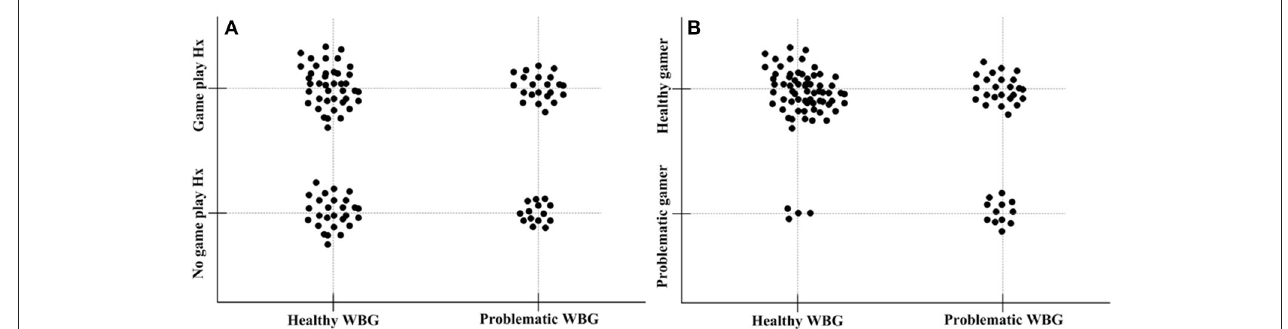
FIGURE 1 | The correlation between internet gaming and web-based board gaming. (A) The correlation between history of internet game play (Game play Hx) and problematic web-based board game play (Problematic WBG). (B) The correlation between history of problematic internet game play (Problematic gamer) and problematic web-based board game play (Problematic